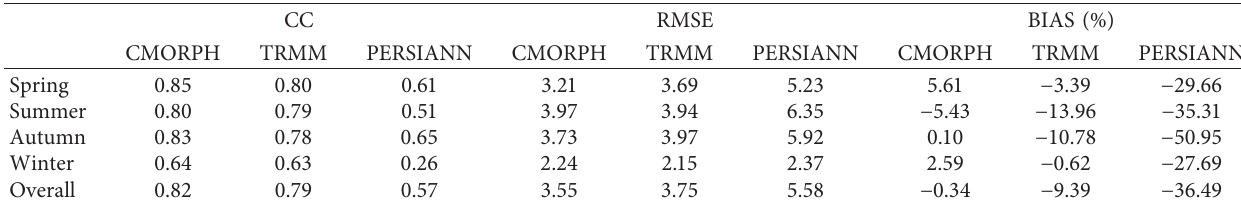
Figure 7: Scatter plot of the observed precipitation and (a) the TRMM, (b) the CMORPH, and (c) the PERSIANN estimates over the Three Gorges Reservoir area in the nighttime. Since the minimum scale of a rainfall gauge was 0.1mm, the observed precipitation less than 1mm was displayed as discrete points on the scatter plot. Table 4: The evaluation metrics of each satellite dataset in